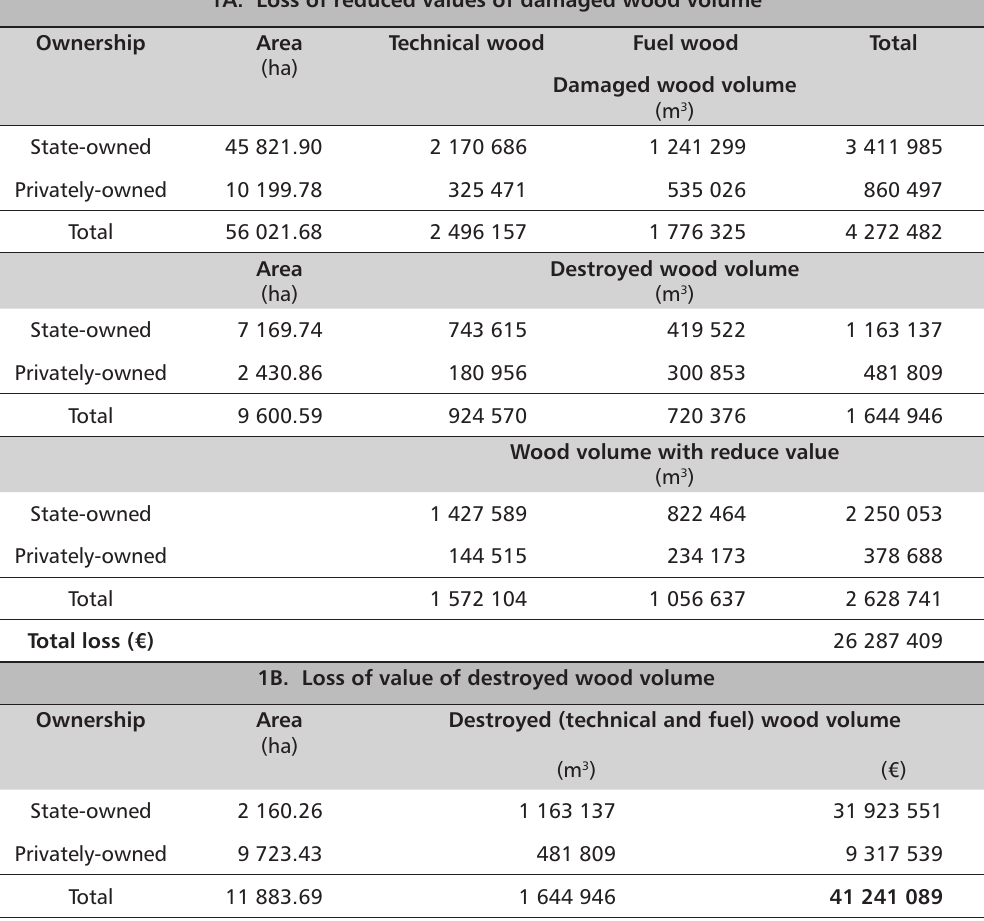
TABLE 2. Loss of values of damaged and destroyed forests (FA Delnice, FA Senj, FA Ogulin) 1A. Loss of reduced values of damaged wood